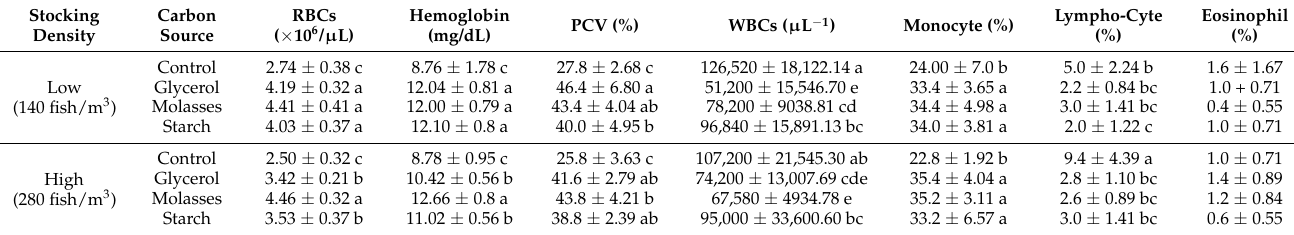
Table 2. Hematological parameters of Nile tilapia juveniles grown at different densities in a conventional intensive culture system and outdoor biofloc technology system (mean ±